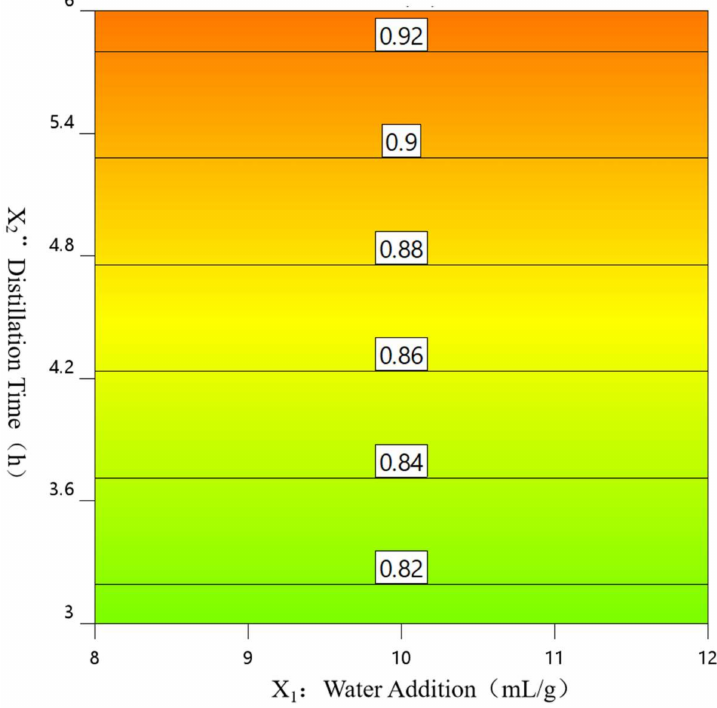
Figure 3. Volatile oil yield at a fixed collection temperature of 10 ◦ C.